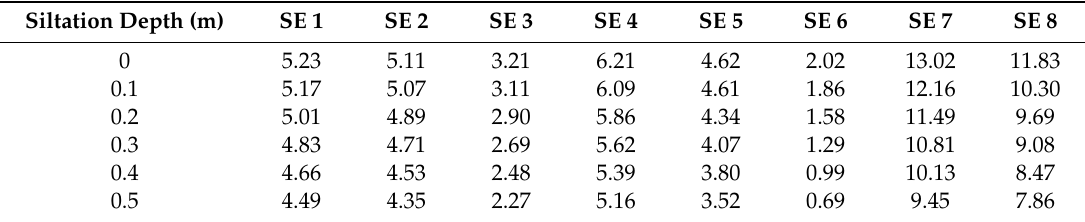
Table 2. E-flow requirements (m 3 / s) for di ff erent river segments (SE) under the high hydrological connectivity scenario with a specified flow velocity of 0.2 m / s.